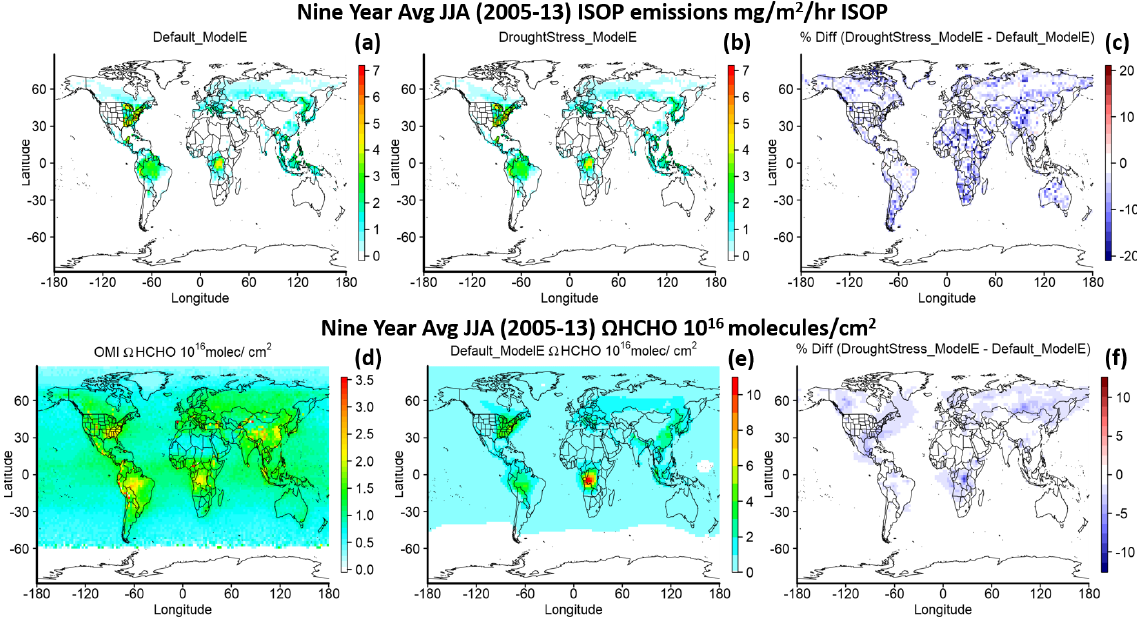
Figure 3. Global 9-year average of JJA 2005–2013 isoprene emissions (first row) for Default_ModelE (a) , DroughtStress_ModelE (b) , and the percent difference between DroughtStress_ModelE and Default_ModelE (c) . (cid:127) HCHO (second row) for OMI (d) , Default_ModelE (e) , and the percent difference between DroughtStress_ModelE and Default_ModelE (f) . Note the different color scales between panels (d) and (e)